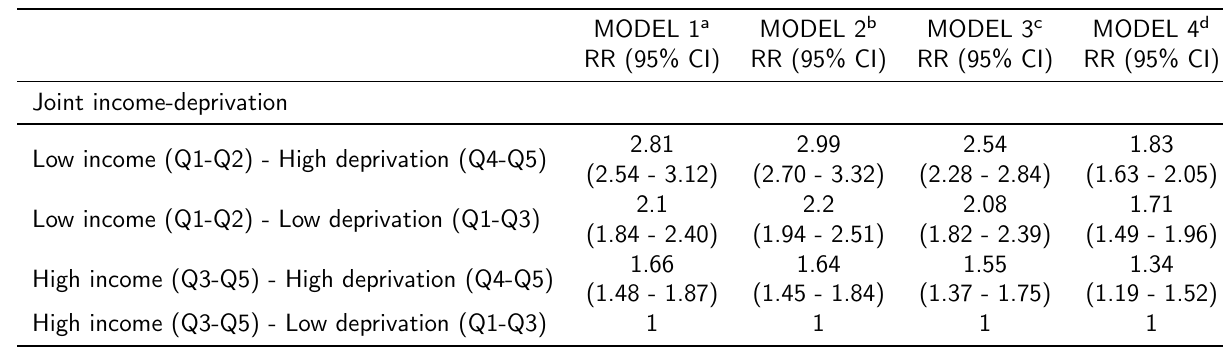
Table 3: Multivariable Sequentially Adjusted Modified Poisson Regression Models with Robust Error Variance for Joint Individual- Level National Household Income Quintile and DA-Level National Material Deprivation Quintile Exposure and Index Prospective ACSC Hospitalization for Pooled CCHS Respondents (Cycles 2000/2001-2011) (N